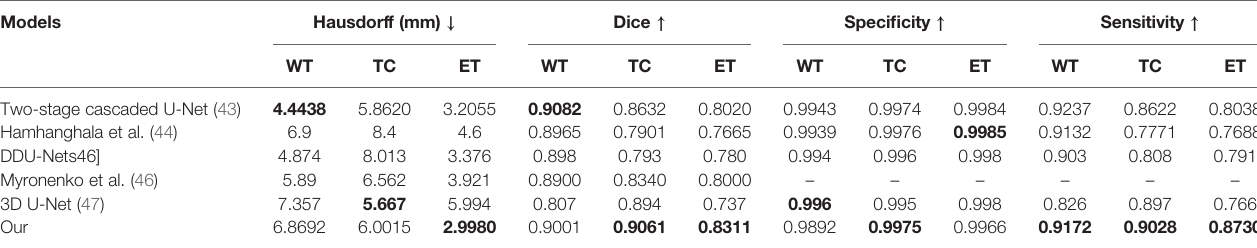
TABLE 3 | Comparison of performance between our approach and the state-of-the-art methods on BraTS 2019 validation set using Dice, Hausdorff distance, speci fi city, and sensitivity metrics.